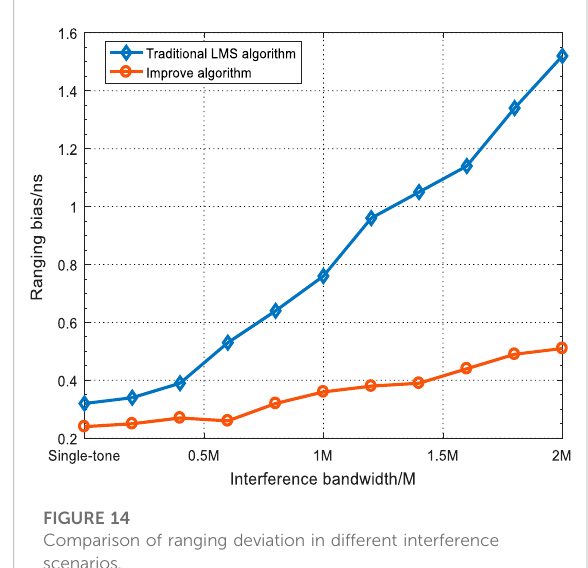
FIGURE 14 Comparison of ranging deviation in different interference